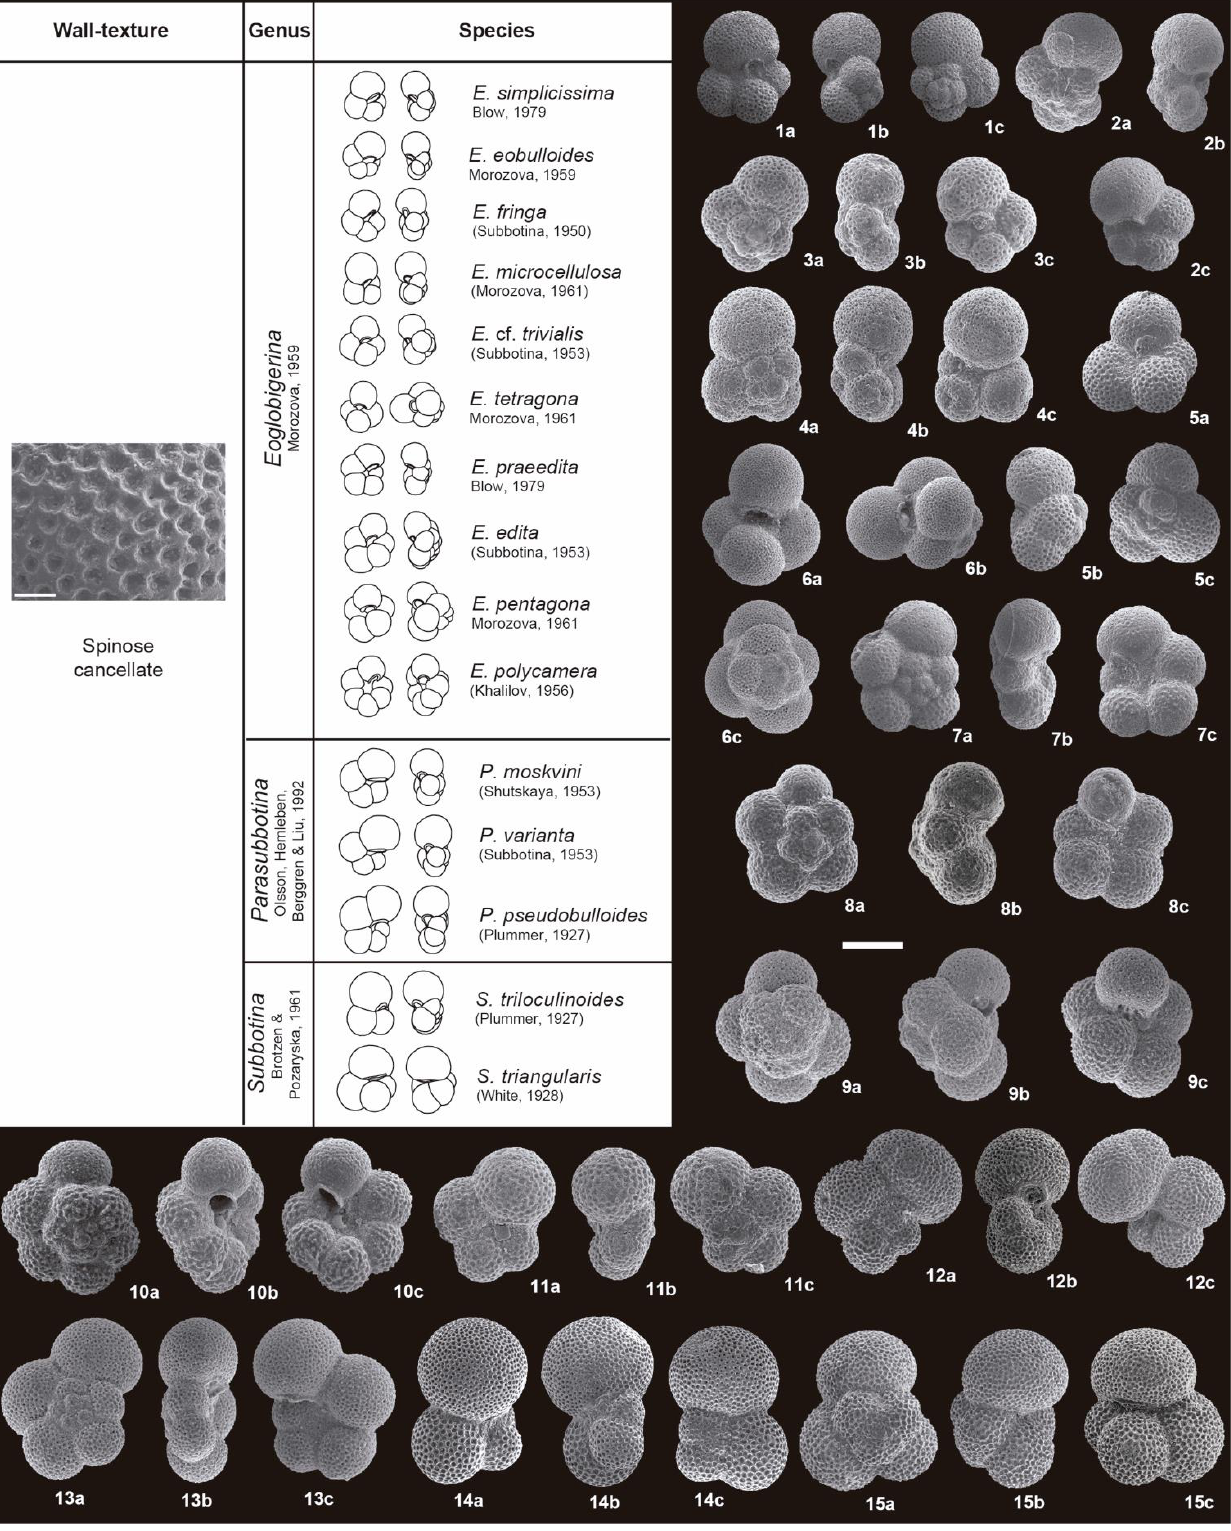
Figure A4. Early Danian species of Eoglobigerina, Parasubbotina , and Subbotina . 1. Eoglobigerina simplicissima ; 2 . E. eobulloides ; 3. E. fringa ; 4. E. microcellulosa ; 5. E. cf. trivialis ; 6. E. tetragona ; 7. E. praeedita ; 8. E. edita ; 9. E. pentagona ; 10. E. polycamera ; 11. Parasubbotina moskvini ; 12. P. varianta ; 13. P. pseudobulloides ; 14. Subbotina triloculinoides ; 15. S. triangularis . See main diagnostic characters of these species and genera in Supplementary Text S1. Specimens are from El Kef (1–4,7), Ben Gurion (5,8,11,12,15), Gebel Aweina (14), and DSDP Site 305 (6,9,10,13). Scale bar = 100 µ